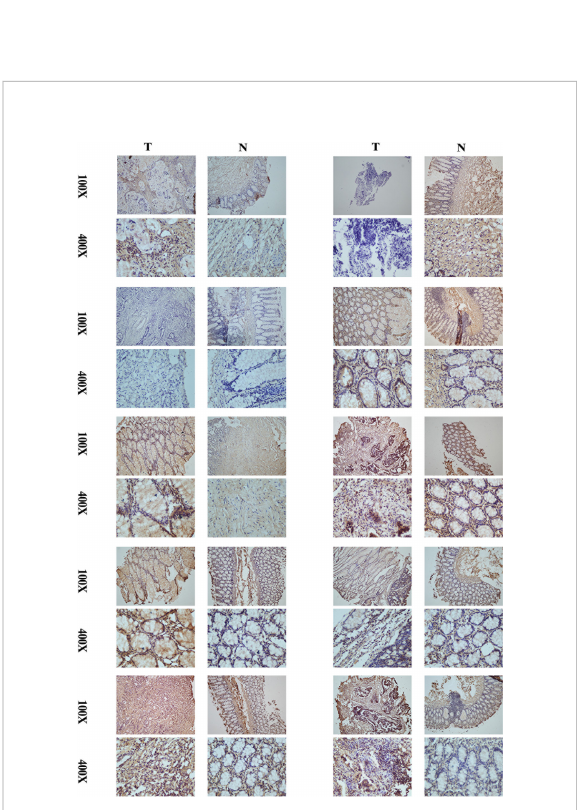
FIGURE 9 Comparison of cancer and paracancer IHC results revealed that CD29 stained signi fi cantly darker in the cancer samples, indicating that their CD29 was highly expressed in colon